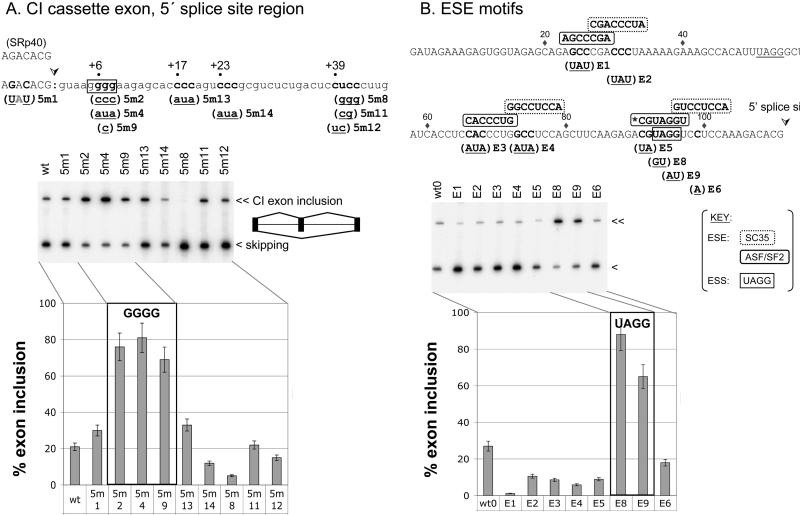
Exonic UAGG and 5′ Splice Site
GGGG Motifs Are Required in Combination for Silencing of the CI Cassette Exon
(A) A
GGGG splicing silencer motif at the 5′ splice site. Top: Sequence of the 5′ splice site region (5′ to 3′) with exonic (uppercase) and intronic (lowercase) nucleotides. Numbering is relative to the first nucleotide of the intron. Arrowhead indicates 5′ splice site. A predicted SRp40 motif overlying the last seven bases of the exon is indicated. Engineered mutations and names of splicing reporters are indicated immediately below the affected nucleotides. Effect of mutations on the pattern of splicing is shown in a 5′ to 3′ arrangement (gel panel and graph). All splicing reporter plasmids have a three-exon structure in which CI is the middle exon (in the schematic, vertical bars indicate exons and horizontal lines indicate introns). Splicing reporter plasmids were expressed in vivo in mouse C2C12 cells, and splicing patterns assayed by radiolabeled RT-PCR of cellular RNA harvested from the cells. PCR primers are specific for the flanking exons. Results of multiple experiments are shown graphically as the average percent of exon included in product (y-axis) for each splicing reporter construct (x-axis).
(B) Analysis of ESE motifs. An exonic UAGG splicing silencer motif overlaps an ASF/SF2 motif. Sequence of the CI exon (5′ to 3′) is shown, with engineered mutations (underscored) and names of splicing reporters indicated immediately below the affected nucleotides (bold). Numbering is relative to the first nucleotide of the exon. Predicted ESE motifs for ASF/SF2 and SC35 are highlighted above the exonic sequence as indicated in brackets. The UAGG motif required for silencing (boxed) is indicated below the overlapping ASF/SF2 motif (asterisk). Effect of mutations on the in vivo pattern of splicing is shown in a 5′ to 3′ arrangement (gel panel and graph).Error bars in (A) and (B) represent standard deviations.